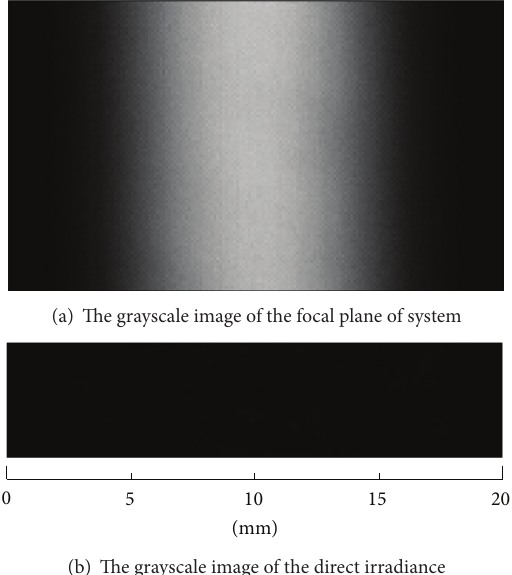
Figure 12: The grayscale image taken by